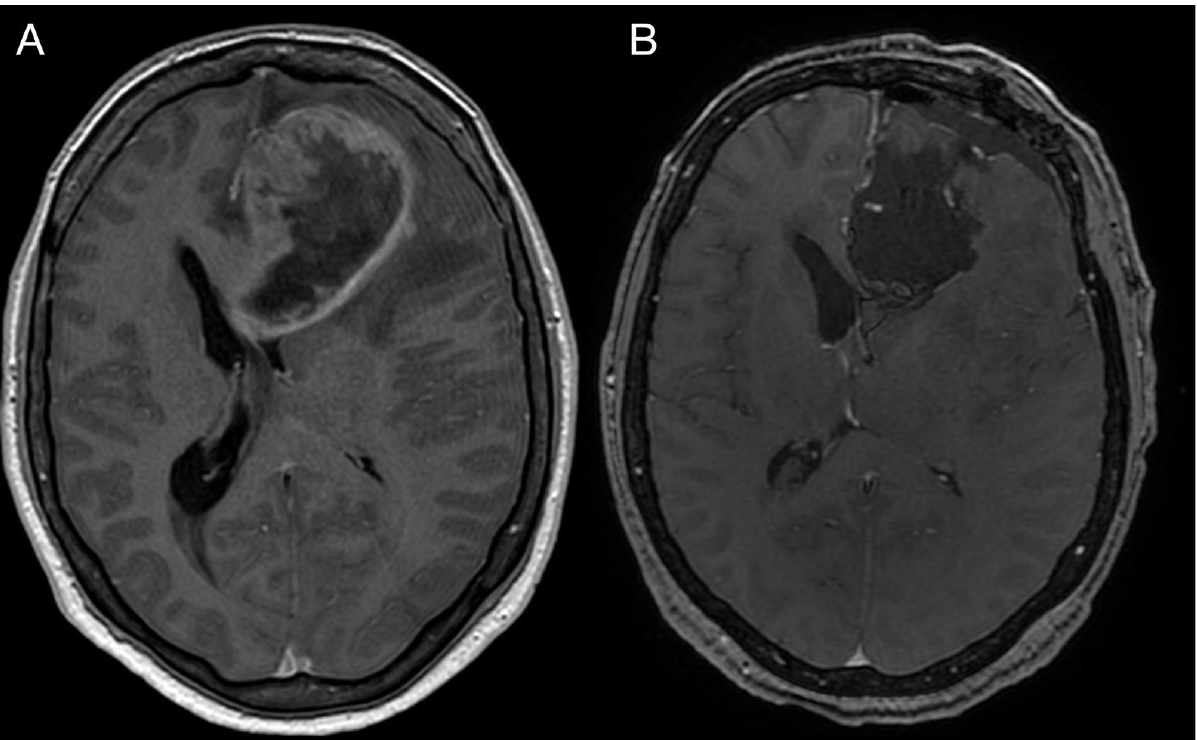
Figure 1. Imaging of the primary brain tumor. Preoperative axial brain MRI (postcontrast T1 weighted images) showing an intra-axial contrast-enhancing lesion in the left frontal lobe with perilesional edema and compression of the adjacent third and lateral cerebral ventricles ( A ). Postoperative MRI is showing total tumor resection. The resection cavity communicates with the frontal horn of the left lateral ventricle ( B ).